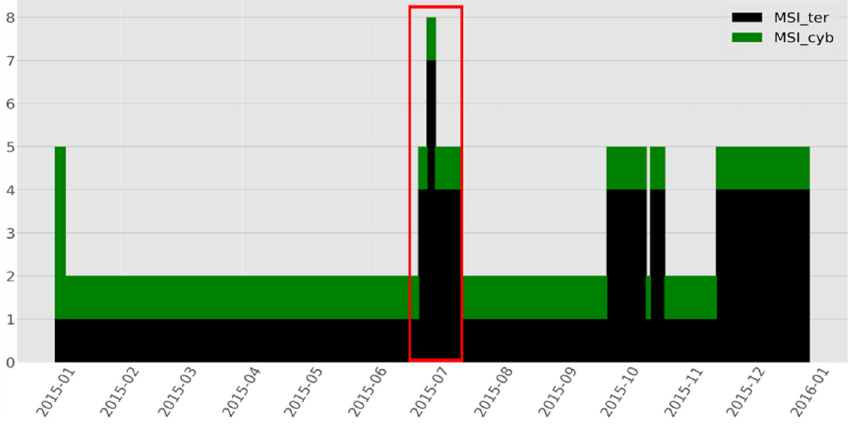
Figure 6. Terrorism and cybersecurity risk-based results ( MSI_ter+MSI_cyb ).